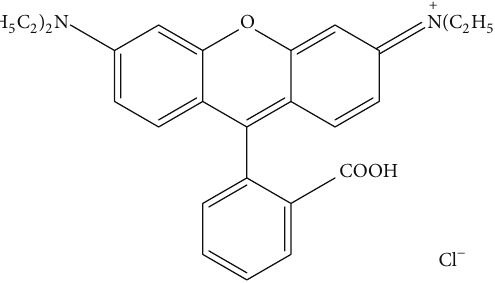
Figure 1: Chemical structure of C.I. basic violet 16